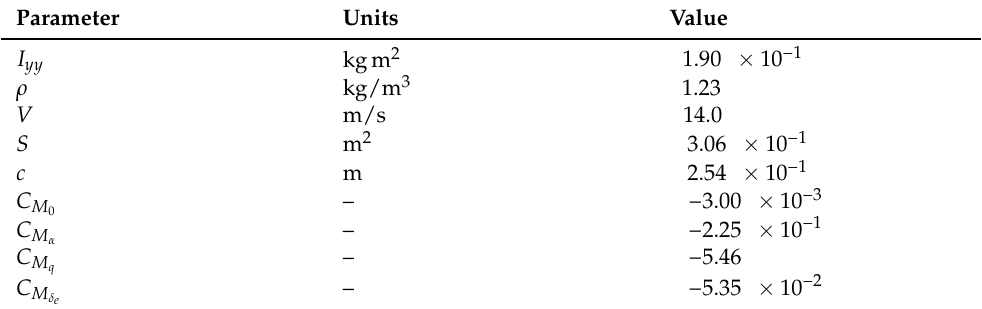
Table 1. Parameters of wind tunnel